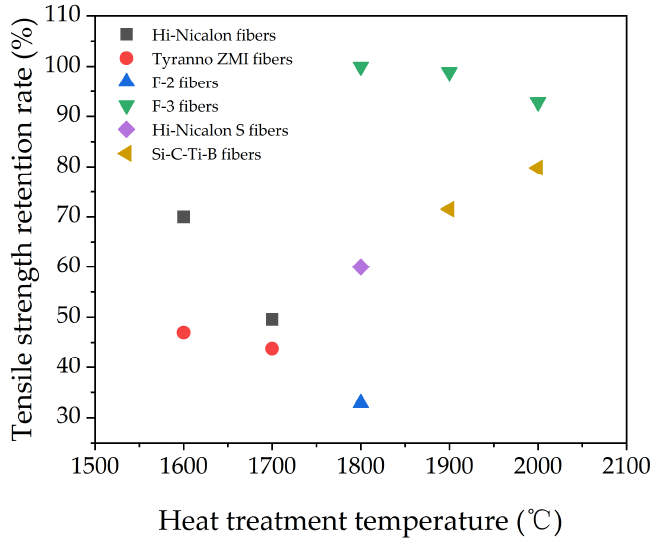
Figure 10. Strength retention rate of Si–C–Ti–B fibers and some commercial SiC fibers after heat treatment at different temperatures under inert atmosphere for 1 h.